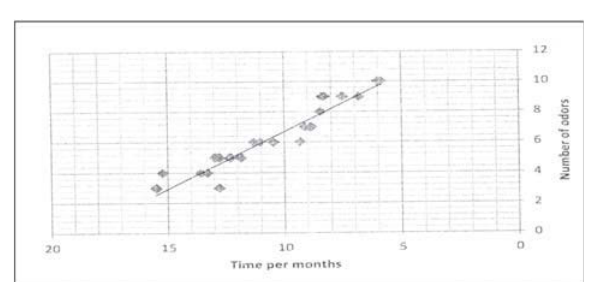
Scatter plot. X axis, number of odors smelled; Y axis, time after operation.